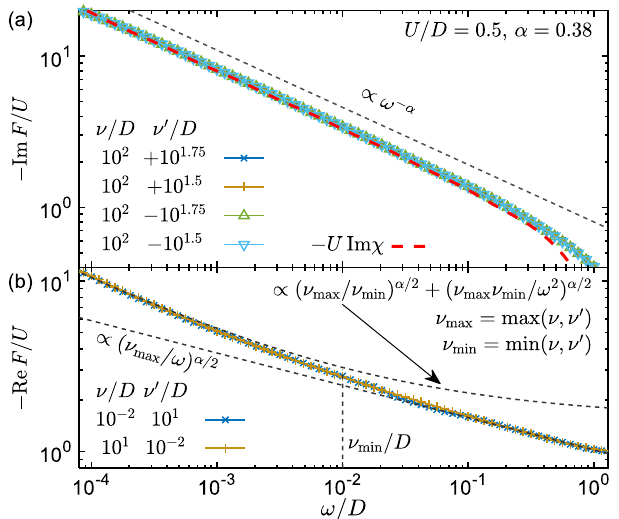
FIG. 6. The ZF 4p vertex − F=U of the MIM, plotted as a function of the bosonic transfer frequency ω for fixed fermionic frequencies ν and ν 0 [cf. Eq. (78)]. (a) The imaginary part of F at ω > 0 . For j ν j ; j ν 0 j ; j ν (cid:4) ν 0 j ≫ D , all results collapse onto a single curve. This curve follows a power law ω − α matching the (2p) susceptibility χ [Eq. (81)], which can be independently computed by NRG (red dashed curve). (b) The real part of F at ω < 0 . If only one of ν and ν 0 is large, F follows two distinct scaling < − ω < ν behaviors for ν and − ω < ν , given, respec- min max min tively, by Eqs. (36) and (40) of Ref. shows a power-law divergence for ω close to the threshold.